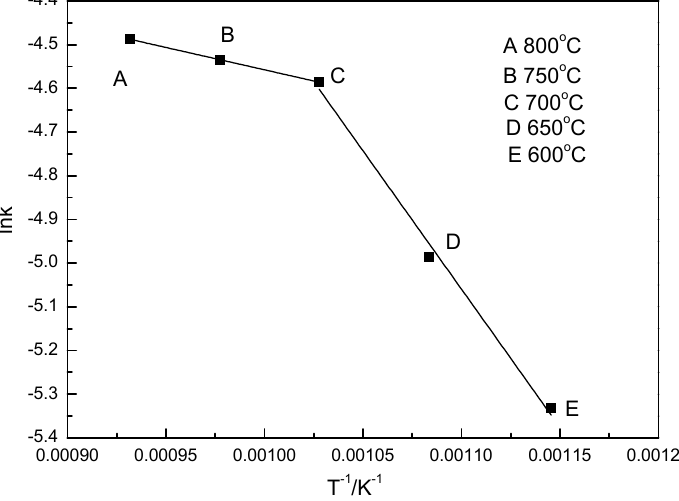
Figure 8. Arrhenius plot for roasting REFCO 3 and REPO 4 .